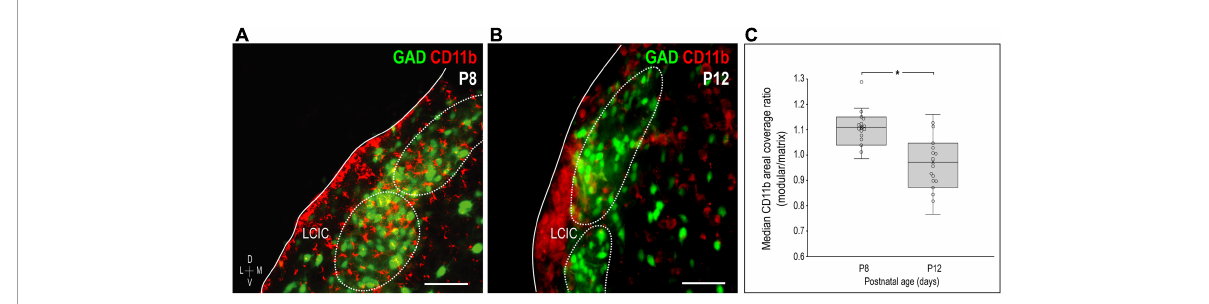
FIGURE4 Changing compartment-specific integrin α M (CD11b) patterns from P8 to P12. CD11b expression (red) at P8 is concentrated in the lateral cortex of the inferior colliculus (LCIC) and most concentrated within glutamic acid decarboxylase (GAD)-positive modules [green, (A) ]. CD11b expression at P12 is complementary to that observed at P8, with labeling that now predominates in the surrounding matrix (B) . Areal coverage analyses for CD11b (C) support qualitative observations, showing significant shifts in CD11b compartmental expression from P8 (primarily modular) to P12 (primarily matrix, * p < 0.01). Scale bars in (A,B) = 50 µ m.